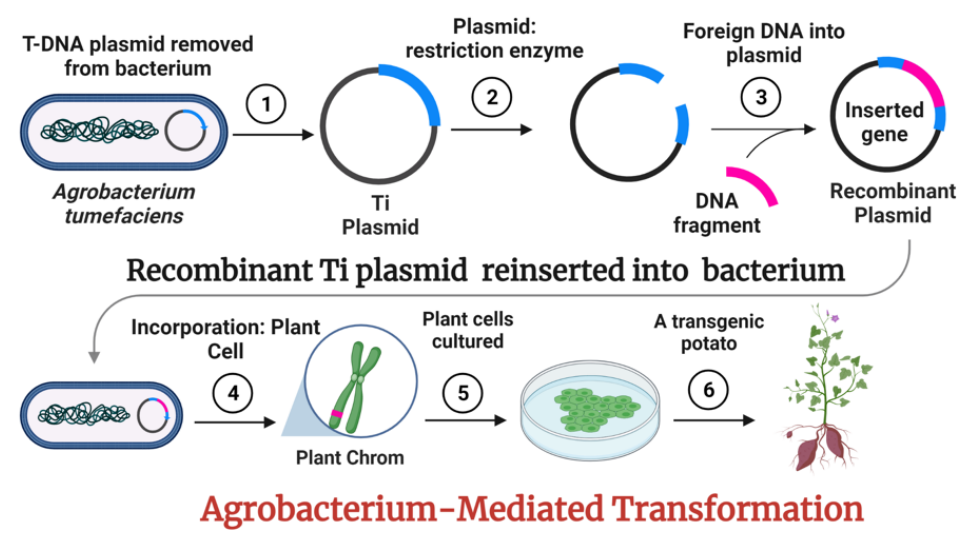
Figure 2. An overview of agrobacterium-mediated gene transformation in plants. ① Ti-Plasmid isolation from parent cell ( Agrobacterium tumefaciens ). ② Digestion of the plasmid with specific endonucleases enzymes. ③ Ligation of foreign DNA into the plasmid. ④ Insertion of recombinant-plasmid into the bacterium and its incorporation into plant’s cell nuclear DNA after infection. ⑤ Growth of transgenic plant tissues artificially. ⑥ Development of transgenic potato grown in a field. Table 2. Comparison of three different kinds of transgenics to improve potato tubers’ quality and quantity.